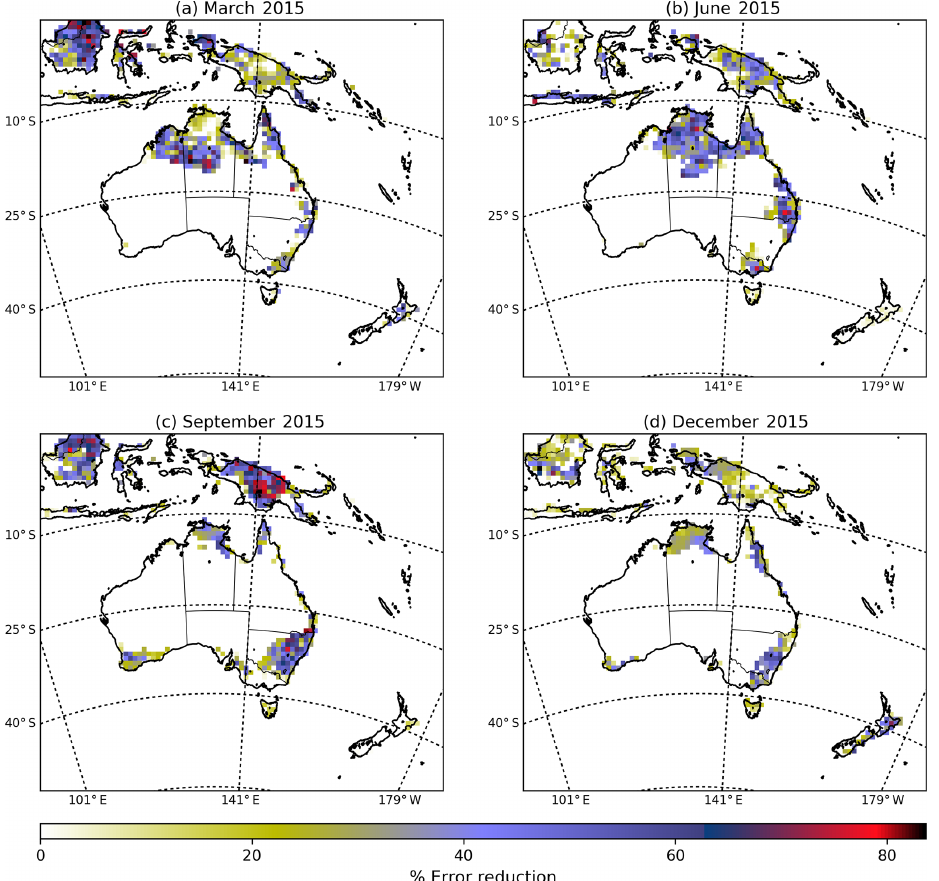
Figure 5. The percentage error reduction of the monthly-mean CO 2 surface fluxes for March, June, September and December 2015 over the CMAQ model domain. The percentage of error reduction is defined as ( 1 − σ a /σ b ) , with σ a and σ b representing, respectively, the posterior and prior uncertainties of the CO 2 fluxes